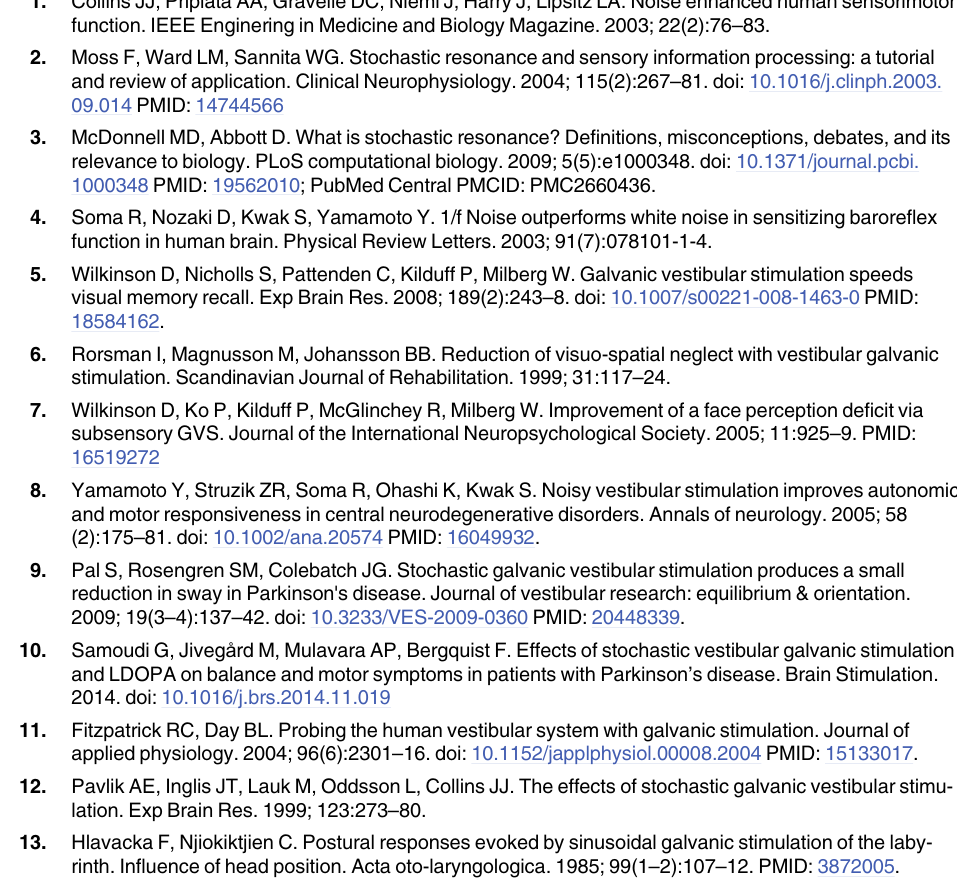
S6 Table. Histograms. This page shows the histogram analyses for the optimal trial stimula- tion amplitude ( μ A) in the ML, AP and APML